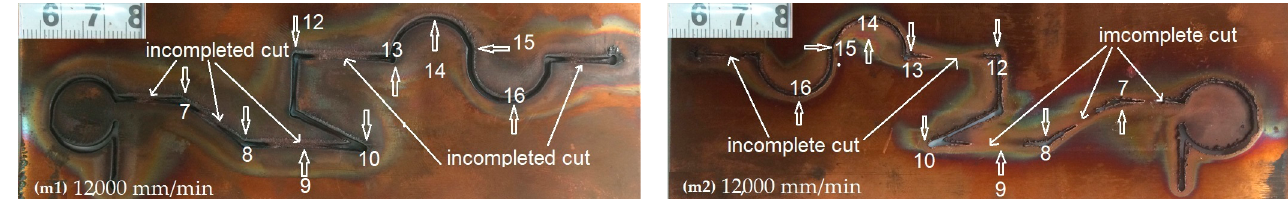
Figure 8. The cutting path width of ( h1 , h2 ) at 7000 mm/min at 30 A for Points 3, 4, 5, and 6. At 12,000 mm/min, at Point 7 (Figure 2) the cutting width with the lowest reading of the obtuse angle had a value of 1316 mm (the cutting width was at the minimum, as were all the readings for the rest of the points). This was already explained in [14]. We found that the feed rate at the maximum produced a minimum cutting width and a higher cut- ting quality. Compared to the minimum feed at 500 mm/min, it had the highest cutting width, which was 2117 mm (Figure 9).